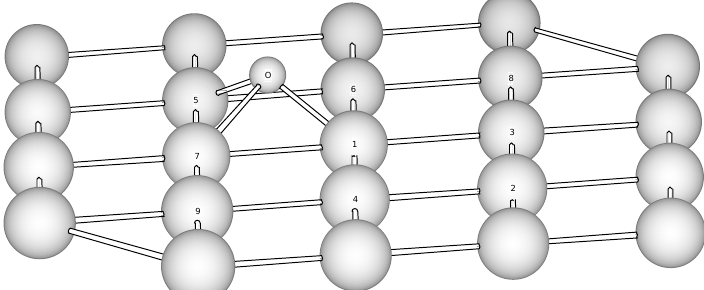
Figure 6. Atomic oxygen adsorption on Fe(110) surface. The only top layer of the cluster is shown for simplicity. Calculated distances (Å) and valence angles (degrees): O-Fe1 1.684, O-Fe5 1.588, O-Fe6 2.320, O-Fe7